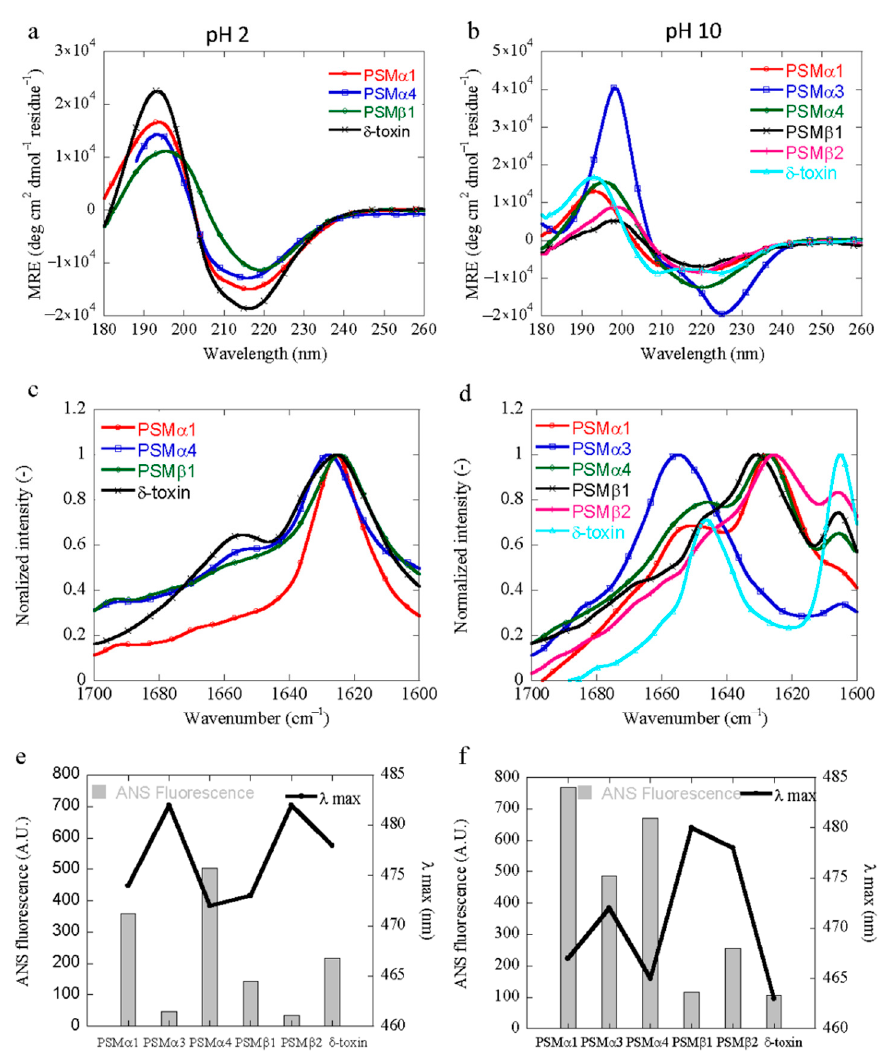
Figure 4. Biophysical structural characterization of PSM fibrils formed under various solution conditions ( a ) Synchrotron radiation CD (SRCD) spectra of different PSMs at acidic pH (pH 2). Spectra of different peptides acquired at the same pH show different minima, and the peak positions are different from each other. ( b ) SRCD spectra of different PSMs at basic pH (pH 10). The variation was modest, as observed at acidic conditions, but almost all peptides show single negative minima. ( c ) FTIR spectroscopy of the amide I’ region (1600–1700 cm − 1 ) of fibrils of PSM variants at acidic (pH 2) solution conditions. PSM α 1, PSM α 4, PSM β 1, and δ -toxin show a peak at 1625 cm − 1 corresponding to rigid intermolecular β -sheet structures, as seen in amyloid fibrils. ( d ) FTIR spectroscopy of the amide I’ region (1600–1700 cm − 1 ) of fibrils of PSMs variants at basic solution (pH 10) conditions. All peptides except δ -toxin show a peak around 1625 cm − 1 corresponding to intermolecular β -sheet fibrillary structures. In contrast, δ -toxin shows two peaks around peaks at and around 1645 cm − 1 , with the latter indicating more disordered fibrils. In contrast, PSM α 3 shows main peaks at and around 1654 cm − 1 , with the latter indicating more disordered fibrils. ( e ) ANS fluorescence intensity and changes in emission maxima ( λ max ) of PSMs at acidic (pH 2) conditions with fixed peptide concentrations. ( f ) ANS fluorescence intensity and changes in emission maxima ( λ max ) of PSMs at basic (pH 10) conditions with fixed peptide